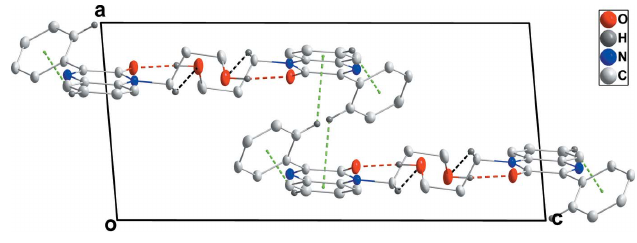
Figure 3 Part of the crystal structure viewed along the c -axis direction showing C— H (cid:2)(cid:2)(cid:2) (cid:2) (ring) interactions as green dashed lines. Hydrogen bonds are as depicted as in Fig. 2.